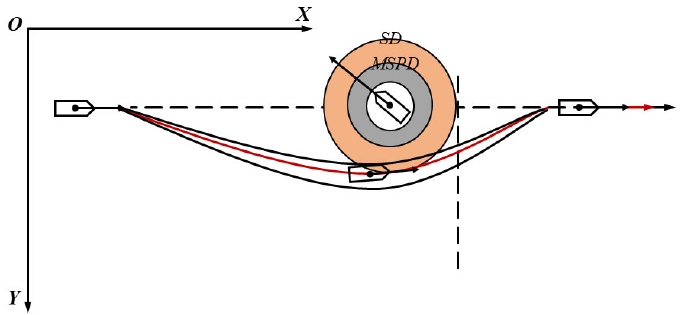
Figure 5. Illustration of the collision avoidance process of a ship at the onshore supervision or fully autonomous level.